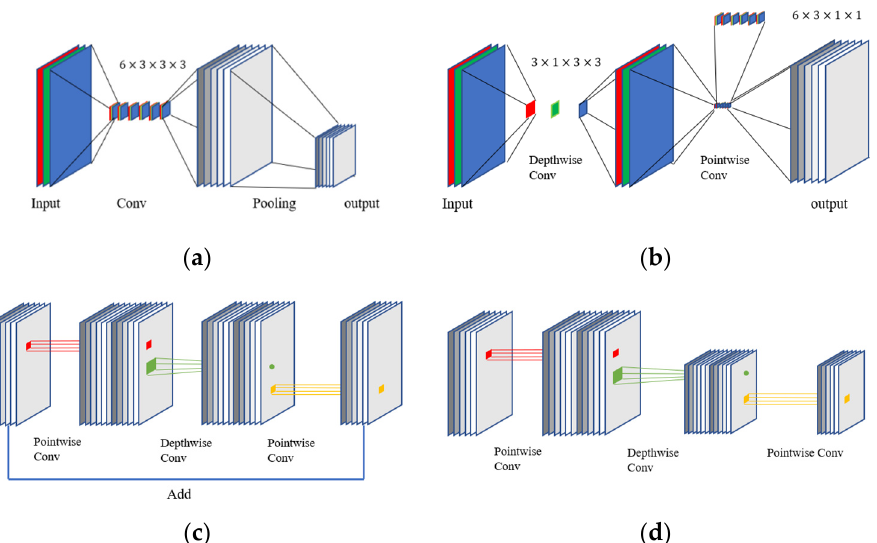
Figure 1. Comparison of convolutional blocks for different architectures. ( a ) Convolution pooling block; ( b ) separable block; ( c ) inverted residual block; ( d ) inverted residual block (stride).